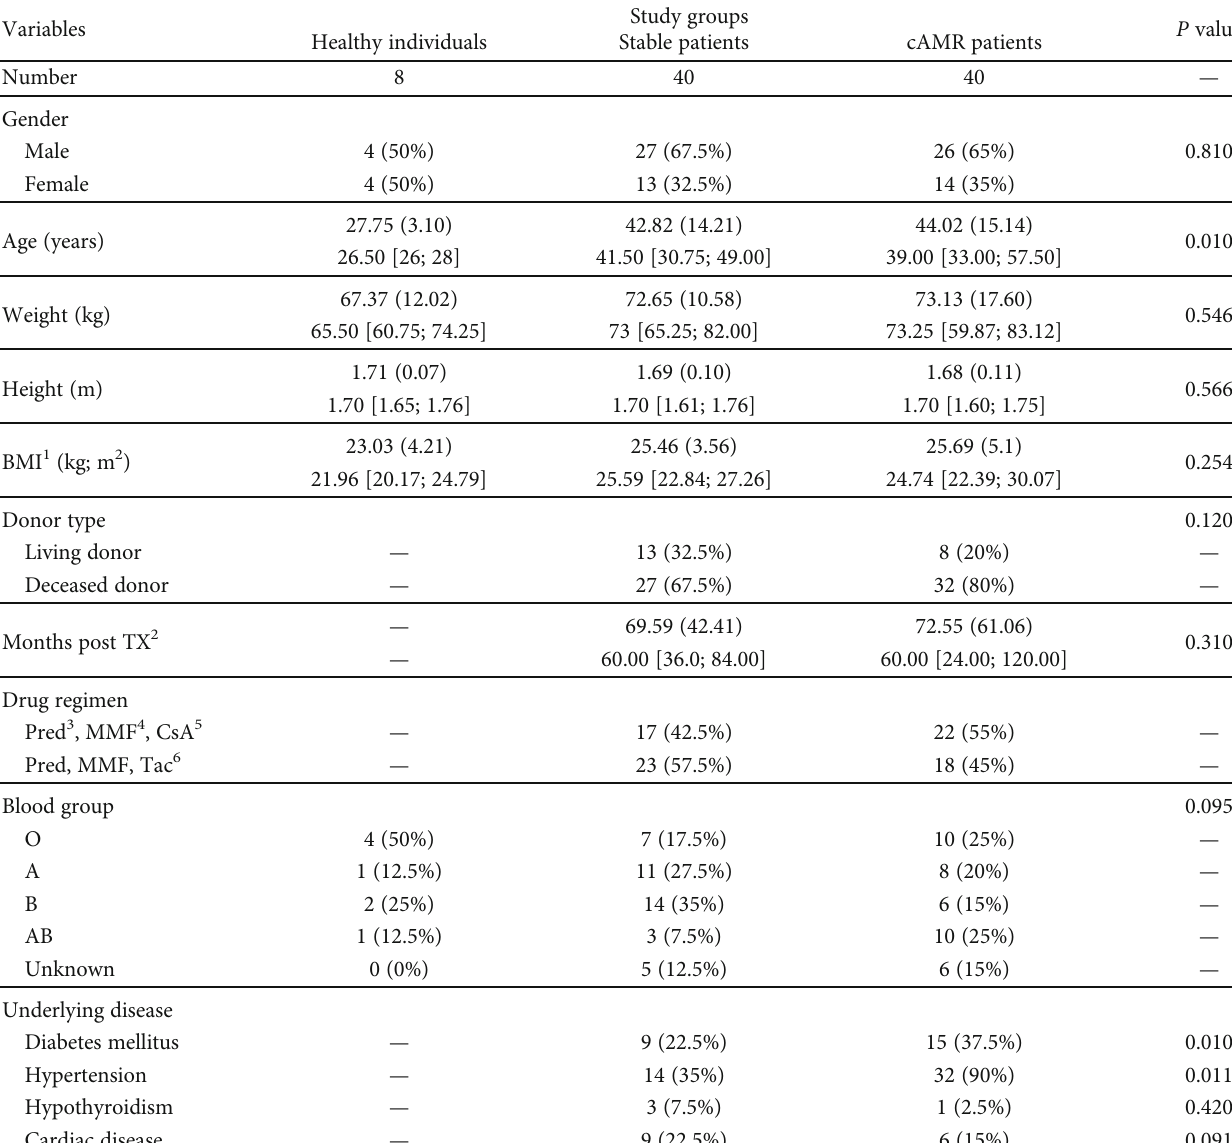
Table 1: Demographic data of study